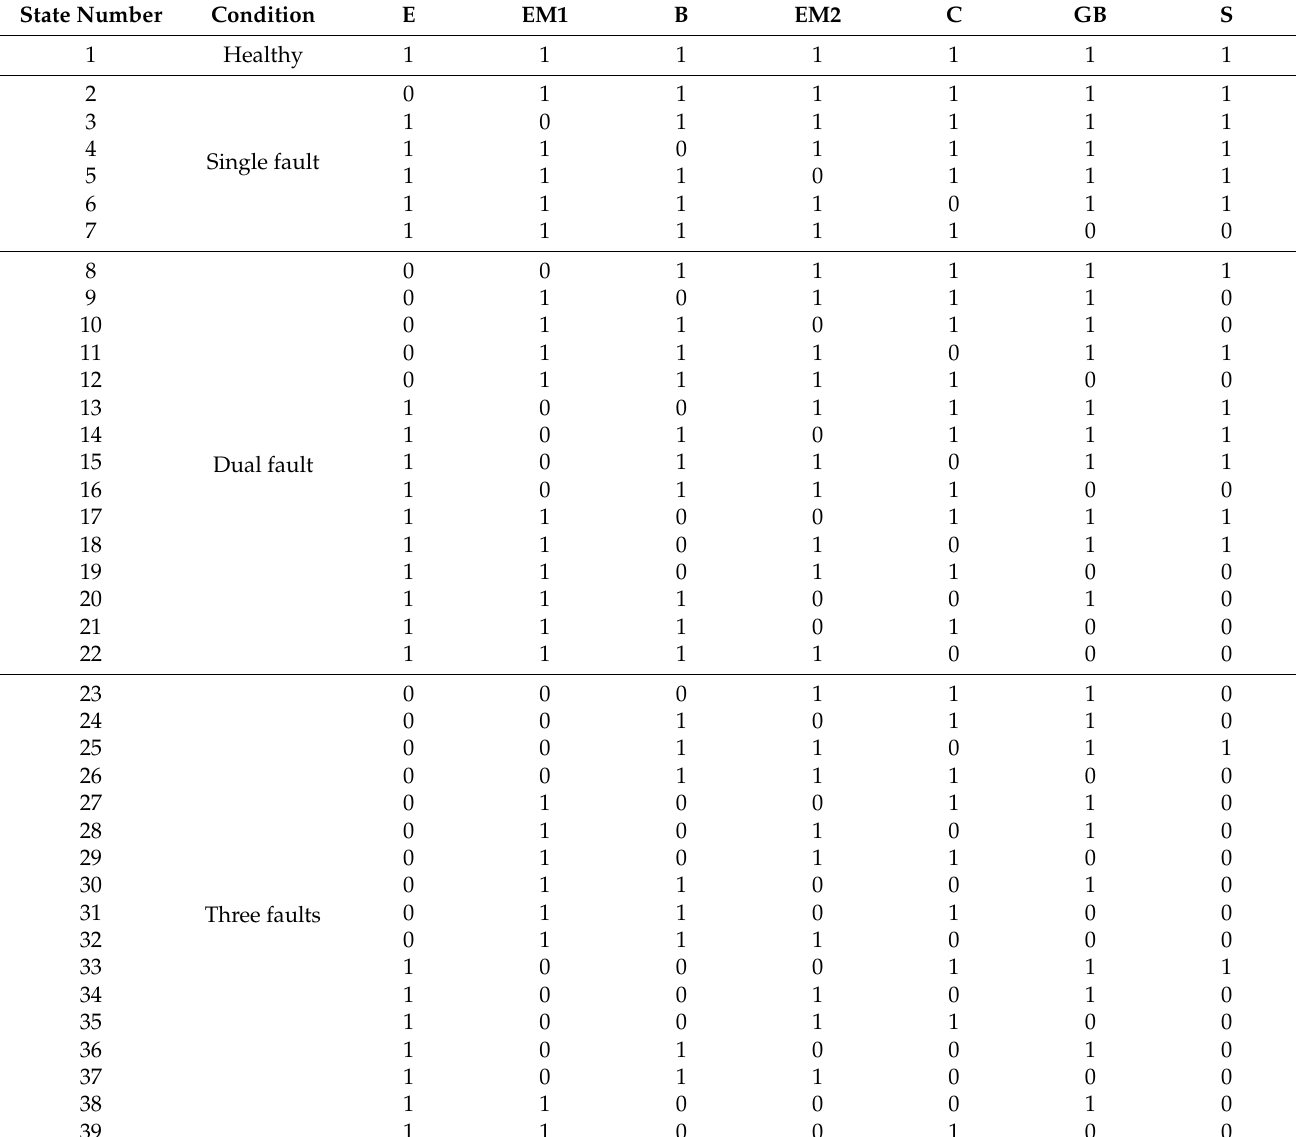
Table A1. States of the proposed series parallel hybrid system (E = engine; EM1 =